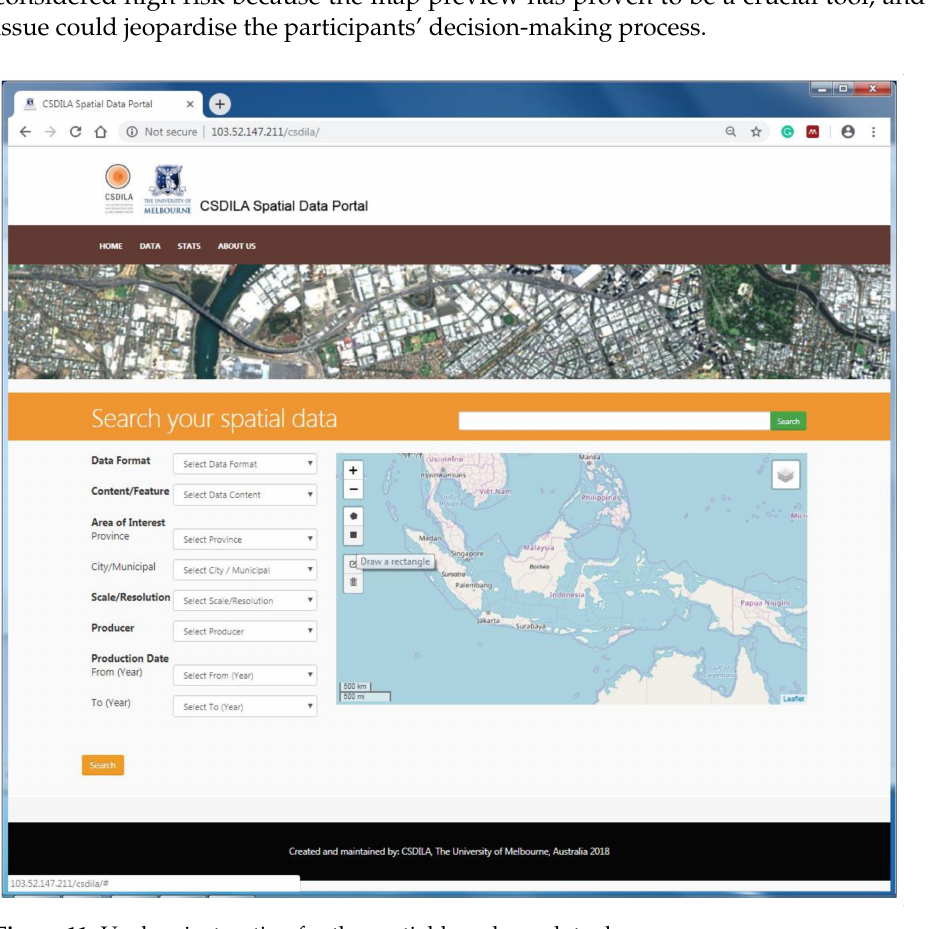
Figure 11. Unclear instruction for the spatial-based search